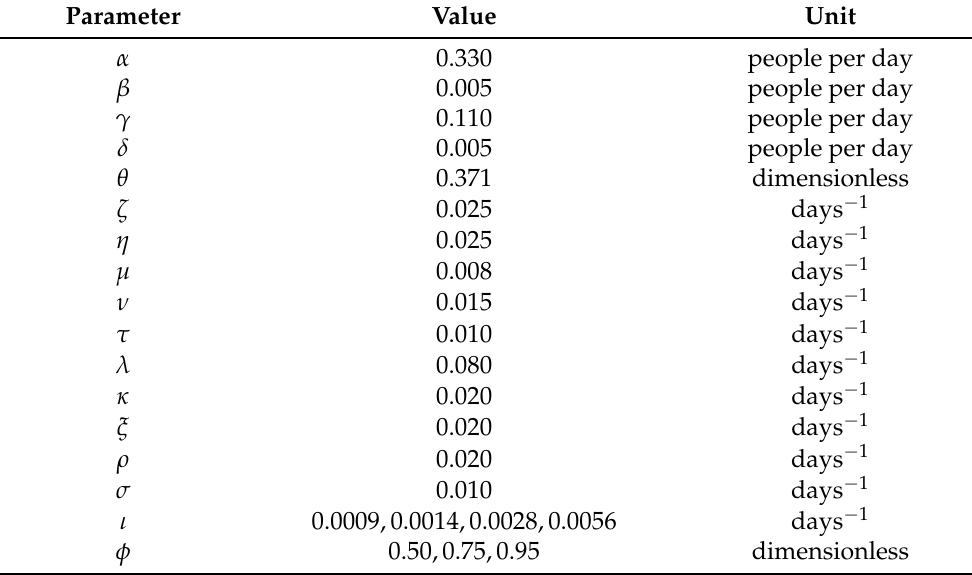
Table 1. Values of the parameters of the SIDARTHE model used in the numerical